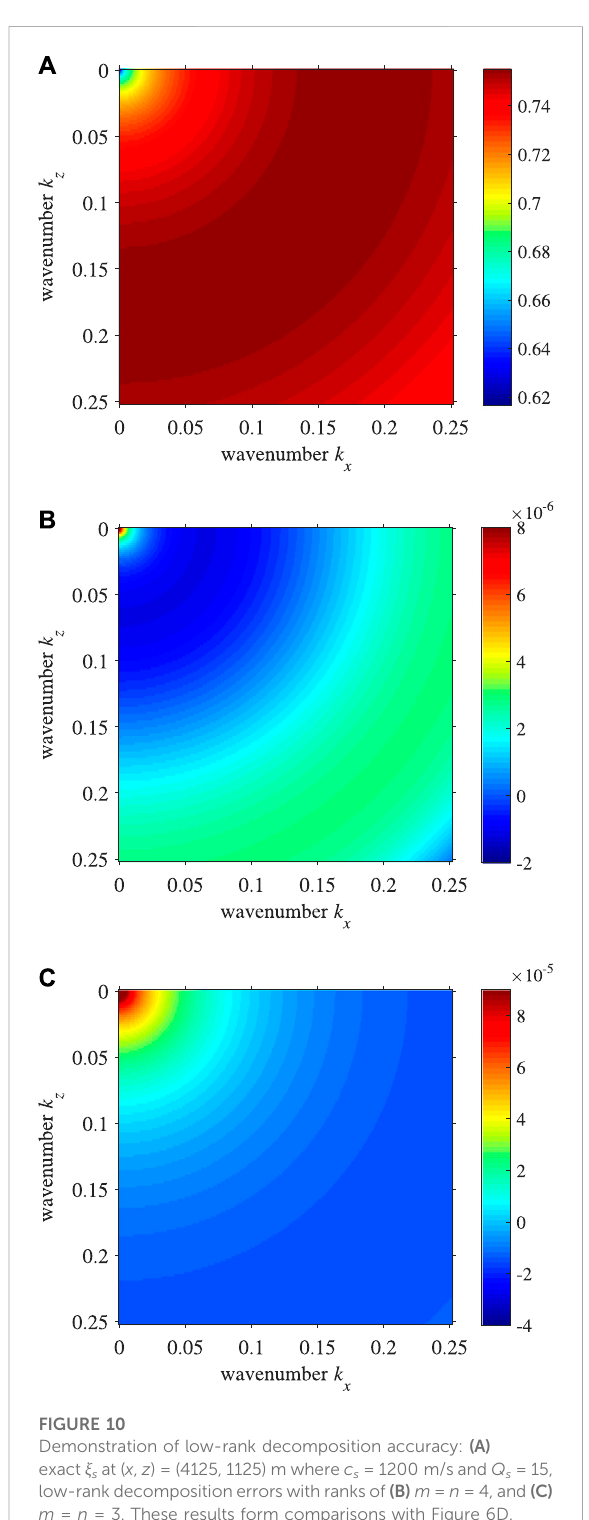
FIGURE 10 Demonstration of low-rank decomposition accuracy: (A) exact ξ s at ( x , z ) = (4125, 1125) m where c s = 1200 m/s and Q s = 15, low-rank decompositionerrorswith ranksof (B) m = n =4, and (C) m = n = 3. These results form comparisons with Figure